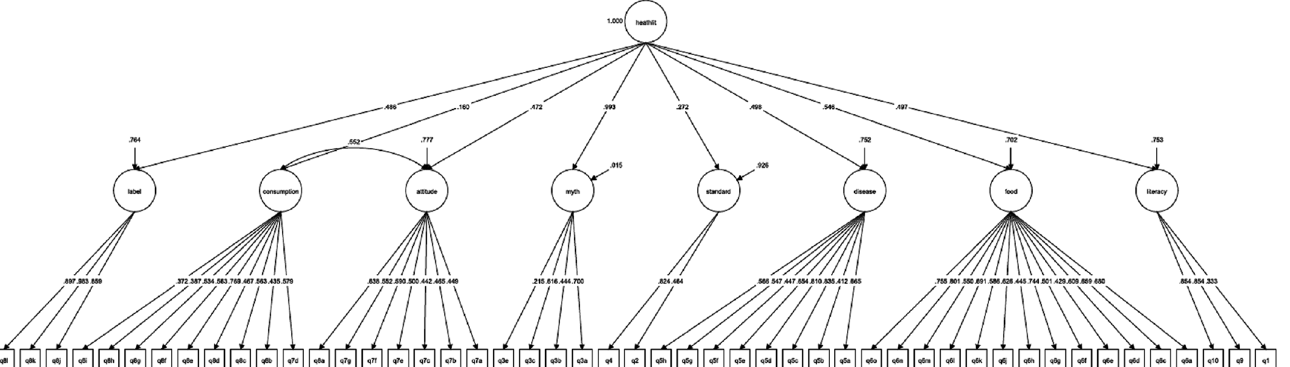
PLOS ONE | DOI:10.1371/journal.pone.0132303 July 6,